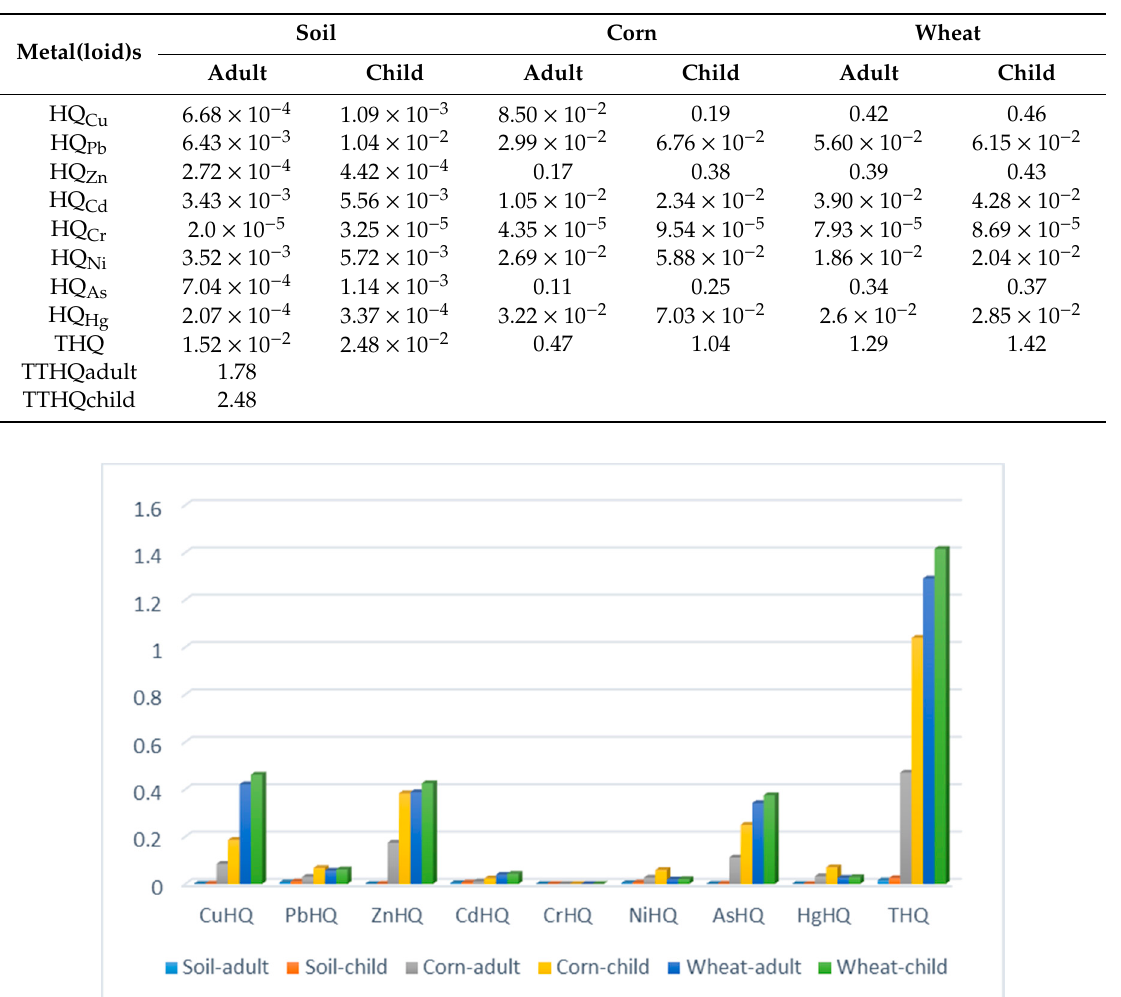
Table 2. Health Risk Quotient (HQ) and target hazard quotient (THQ) statistics of three paths (soil, corn, wheat).